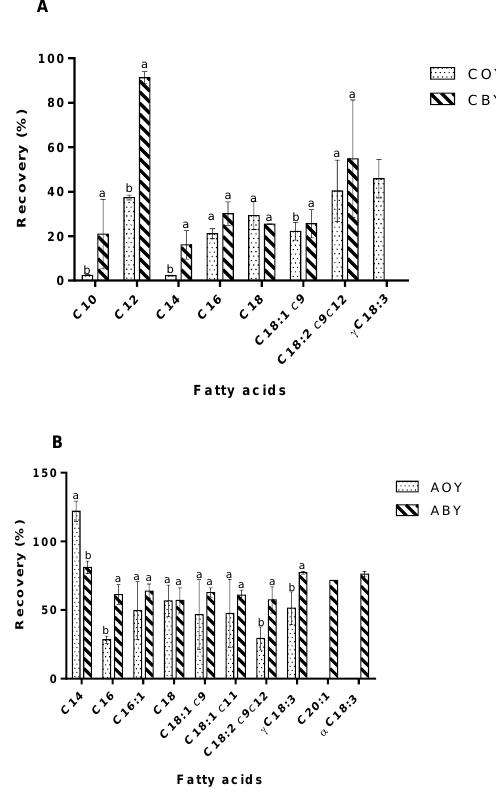
Figure 1. Recovery percentages of fatty acids in fortified yogurts (( A ) coconut oil yogurts, ( B ) avocado oil yogurts). Different letters mean significant differences between yogurts as determined by a one-way ANOVA test ( p < 0.05). CT—control yogurt, COY—coconut oil yogurt; CBY—coconut bigel yogurt; AOY—avocado oil yogurt; ABY—avocado bigel yogurt.